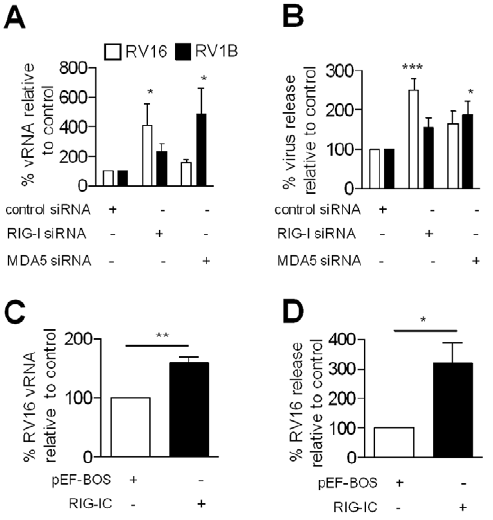
Figure 6. Effects of RIG-I and MDA5 abrogation on RV replication in HBECs. HBECs were transfected with siRNA specific for RIG-I, MDA5 or control siRNA, infected with RV1B or RV16 and vRNA determined by PCR at 24 h (A) or RV release by titration at 48 h (B). BEAS-2B cells were transfected with 0.5 m g RIG-IC or pEF-BOS control, and RV16 vRNA (C) and virus release (D) determined. mRNA data was generated from 5 independent experiments utilizing 3 independent HBEC donors, 2 experiments per donors 1,2 and a one experiment for donor 3; and 4 independent experiments for BEAS-2B cells.